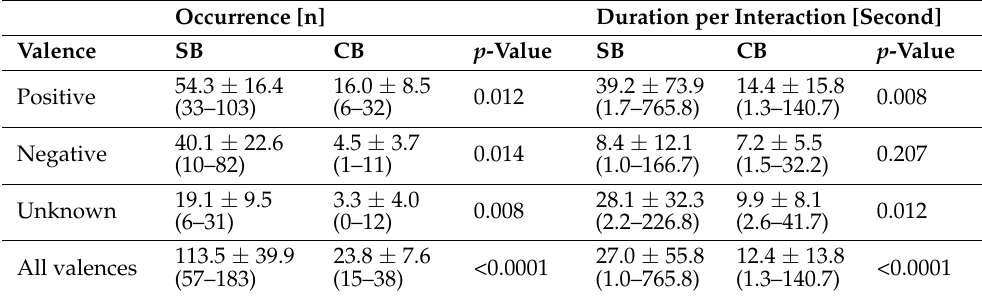
Table 4. Occurrence of social interactions (mean ± SD (range)) during 24 h and duration per interaction (mean ± SD (range)) in the social box and the conventional box stabling by valence. Occurrence